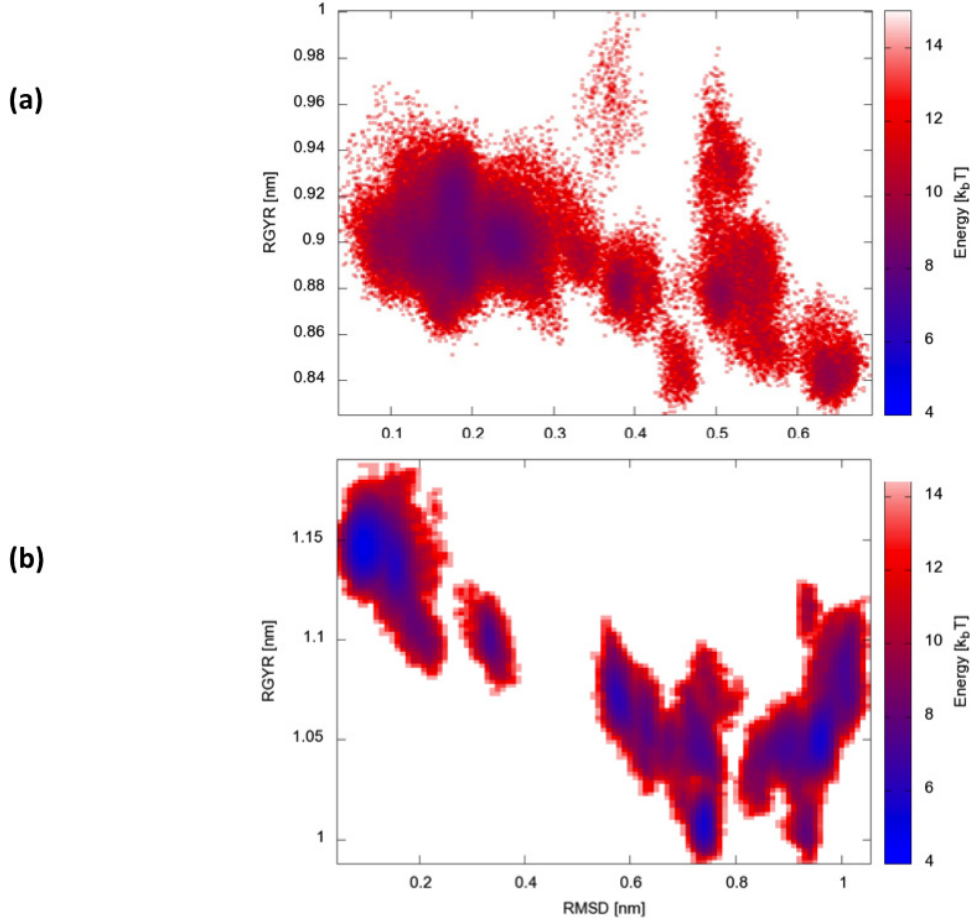
Figure 6. Two-dimensional representations of the free-energy landscapes for the two simulated proteins calculated on the root mean square deviation (RMSD) of the backbone atoms from the reference structure and the radius of gyration of the proteins. ( a ) HP35; and ( b ) Protein